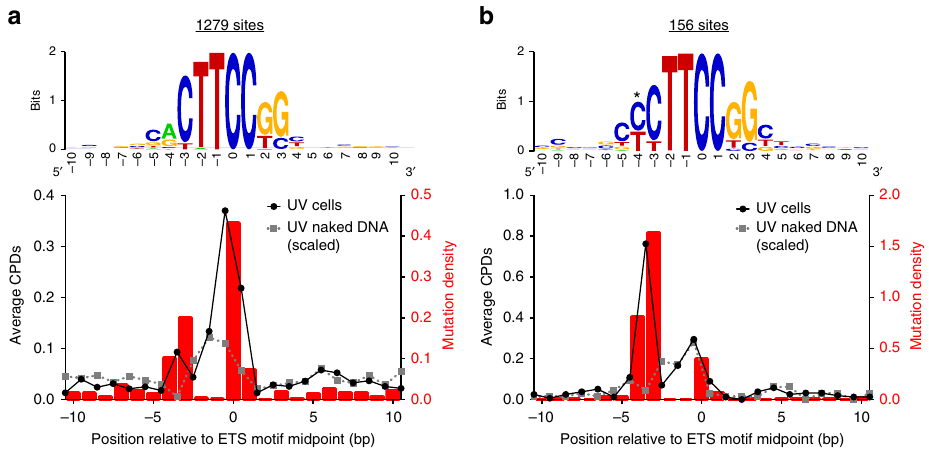
Fig. 4 CPDs and mutations are elevated at speci fi c locations in ETS binding sites. a UV-induced CPD formation and mutation density is enriched at 1279 active, promoter-proximal TFBS for the ETS TFs ELK4, ETS1, and GABPA. TFBS were aligned based on DNA strand and location of ETS consensus sequence. The upper panel depicts the information content of the DNA sequences for the aligned TFBS, matching the known ETS consensus motif. Sequence logo was generated using the weblogo tool 57 . The lower panel plots the mutation density for 184 melanoma tumors relative to average CPD levels following UV- irradiation of NHF1 cells and isolated DNA in vitro (naked DNA). CPD values are plotted at half integer locations, which re fl ect the average number of CPD lesions forming between the two adjacent nucleotides. CPD lesion density for naked DNA was scaled so that the total CPD levels in promoter-proximal regions in cells and naked DNA were equivalent. b Analysis of CPD lesion formation and mutation density at a subset of ETS TFBS (156 sites) that have a pyrimidine nucleotide at position − 4 relative to the ETS motif midpoint (indicated with *), and thus can form CPD lesions between position − 4/ − 3. Upper and lower panels are the same as in part ( a ), plotted for this TFBS